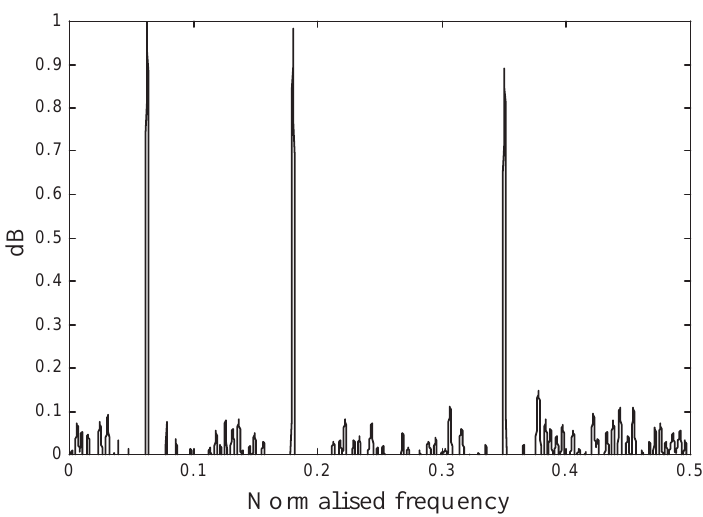
Fig. 5. Estimated indicator R q ( f ) on the signal of Fig. 1, with q = 2 . Note that the pure tone at f = 0 . 0625 is correctly indicated, but the two resonances at f = 0 . 18 and f = 0 . 35 are incorrectly recognised as tones. Virtually similar results have been obtained using the Minimum Variance estimate, however at the price of much more severe computational